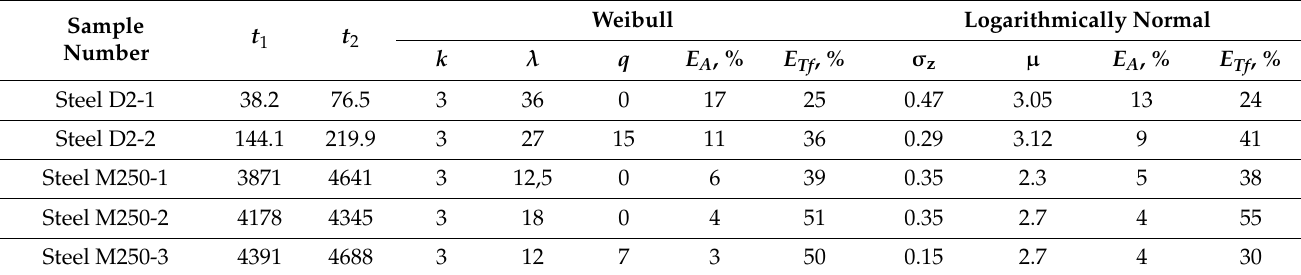
Table 3. Distribution parameters of the structural